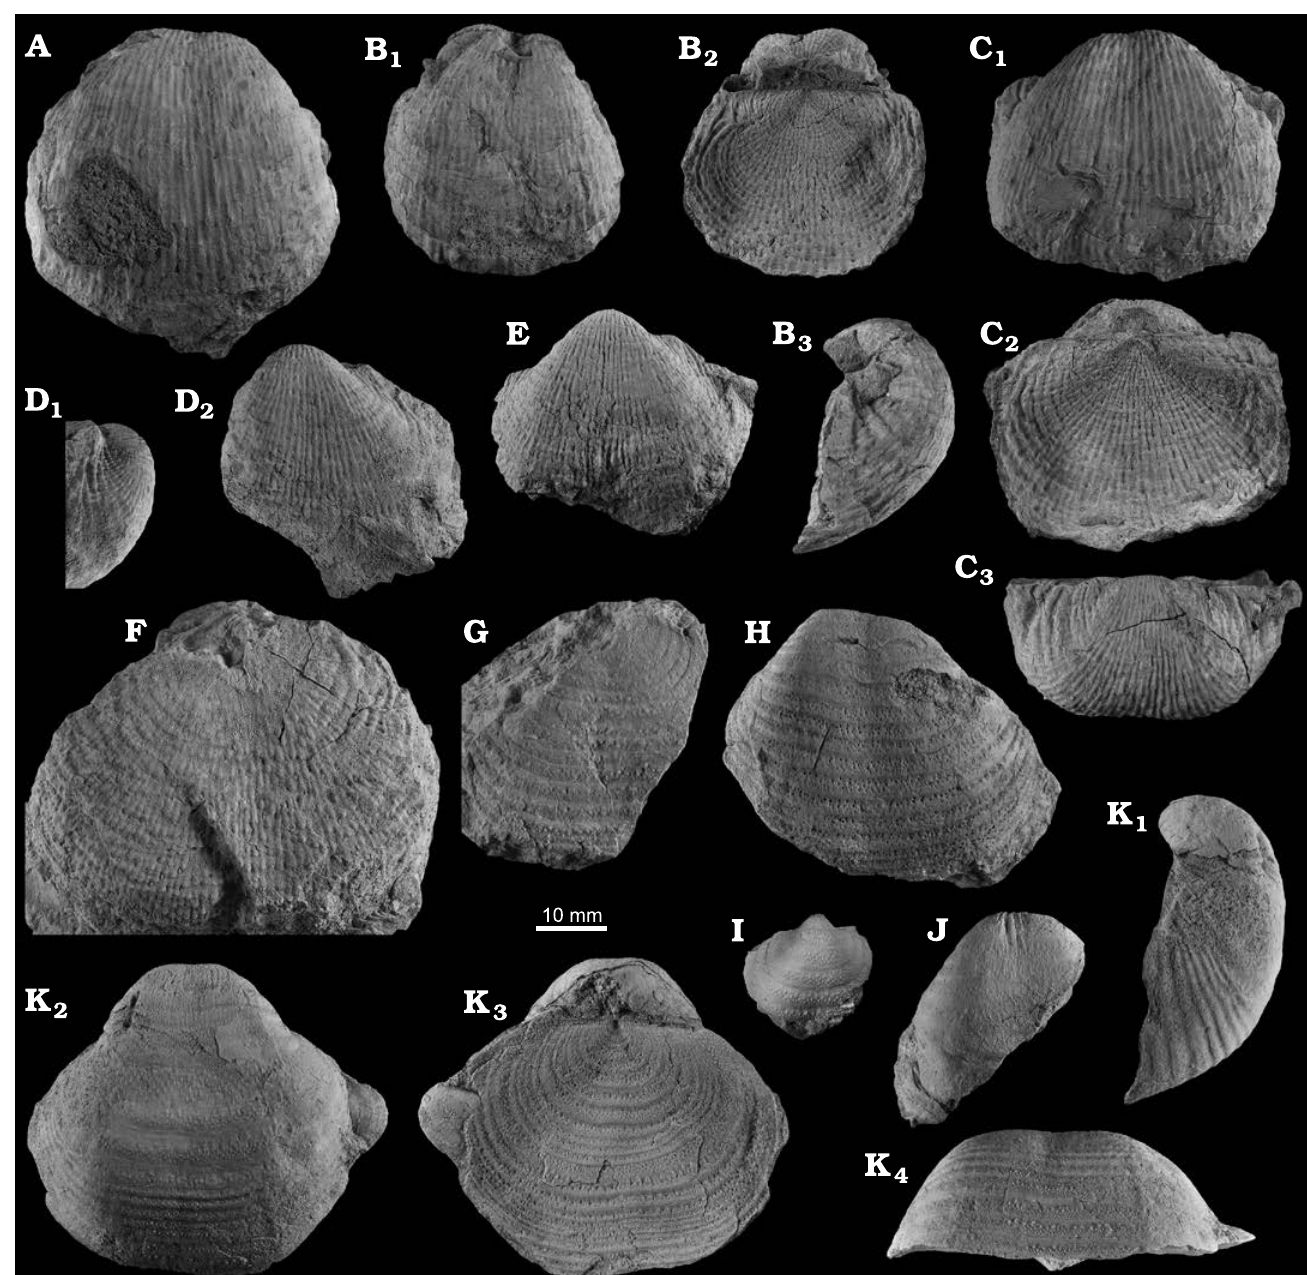
Fig. 12. Productidae and Echinoconchidae from the Brigantian (uppermost Visean) of Ricklow Quarry, near Monyash (localities RCC-, RCK-; see Fig. 3) and Wensley Dale, near Matlock (locality WI1; Fig. 2), Derbyshire, UK. A – C . Buxtonia scabricula (Sowerby, 1814). A . MPUM11963 (WI-40) in ventral view. B . MPUM11962 (WI1-38) in ventral (B 1 ), dorsal (B 2 ), and lateral (B 3 ) views. C . MPUM11961 (WI1-14) in ventral (C 1 ), dorsal (C 2 ), and posterior (C 3 ) views. D , E . Buxtonia sp. D . MPUM11968 (RCC8-2a) ventral valve in lateral (D 1 ) and ventral (D 2 ) views. E . MPUM11969 (WI1-2) ventral valve in ventral view. F . Buxtoniini gen. et sp. indet., MPUM11971 (RCK15B-1a) dorsal valve external cast. G – K . Echinoconchus punctatus (Sowerby, 1822). G . MPUM11983 (RCC1B-18) dorsal valve external cast. H . MPUM11980 (RCC54-7) ventral valve in ventral view. I . MPUM11975 (RCK15-21) in ventral view. J . MPUM11974 (RCC72-1) in ventral view. K . MPUM11977 (WI1-28) in lateral (K 1 ), ventral (K 2 ), dorsal (K 3 ), and anterior (K 4 )